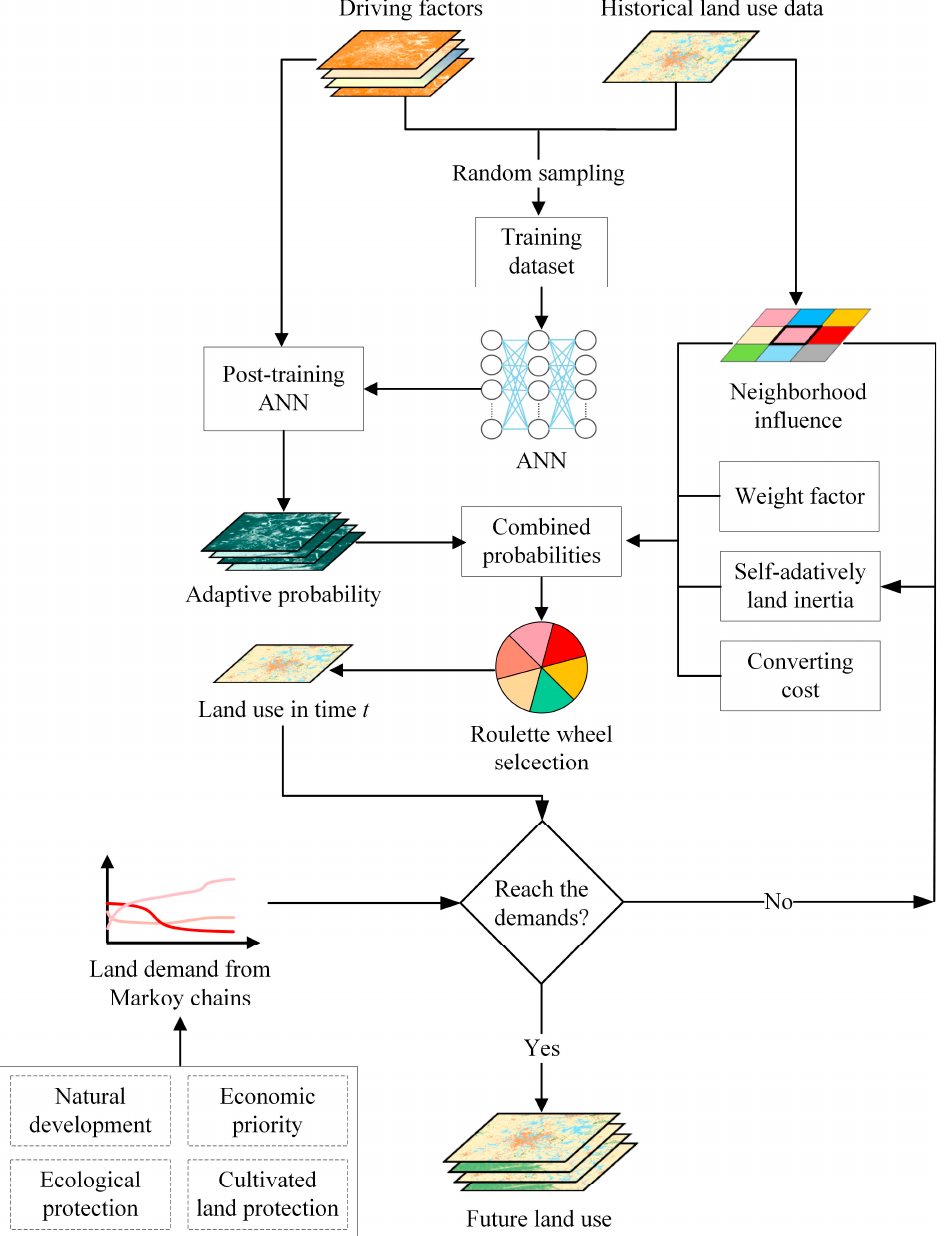
Figure 2. Research design for this